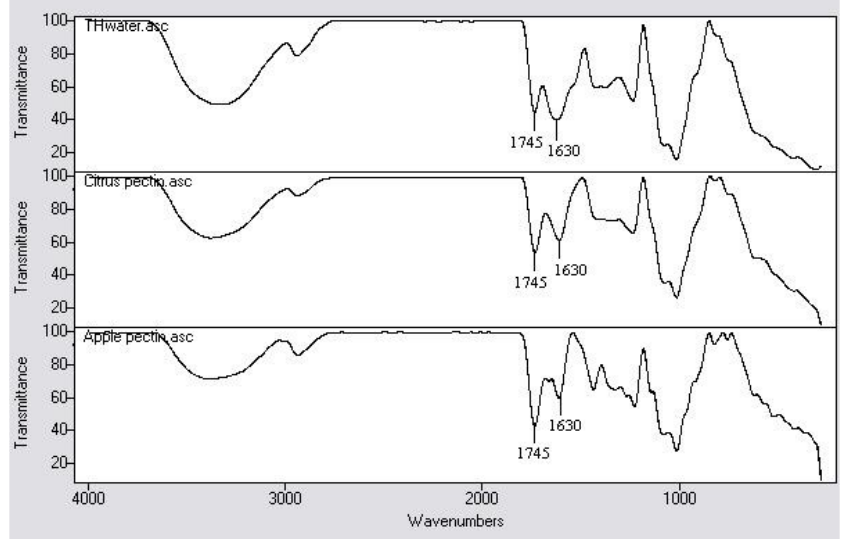
Figure 4. FT-IR spectra of tamarillo hydrocolloid (TH